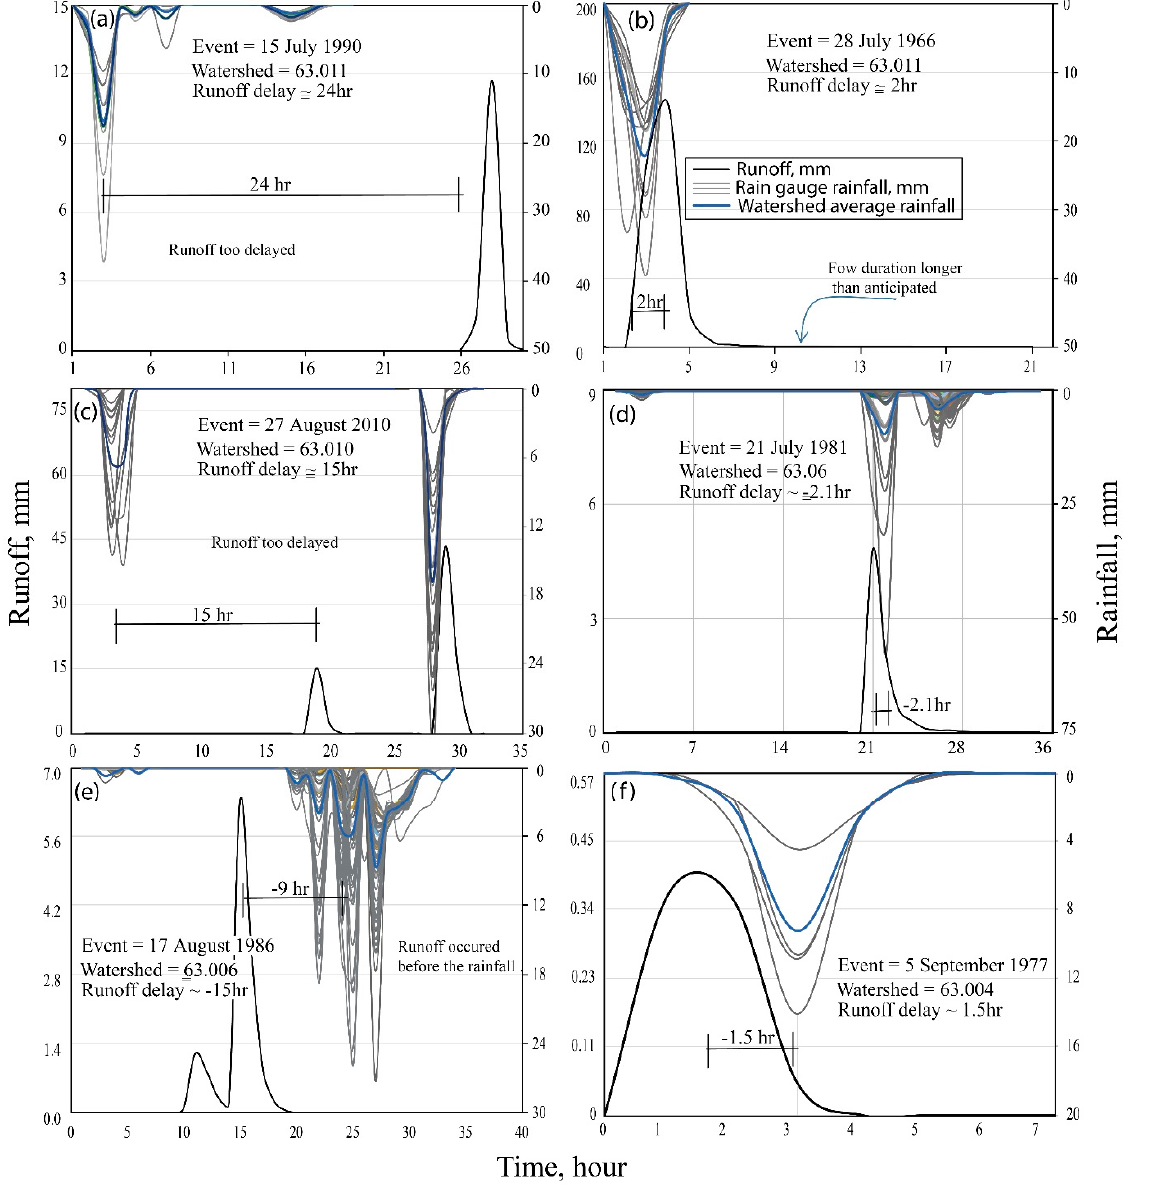
Figure 8. Examples of flagged runoff events, showing runoff (black line) and rainfall from multiple gauges (gray lines) on the inverted y-axis. The solid blue line represents conditional mean of the different rain gauges in the watersheds. The figure shows excessively delayed runoff in ( a , c ), runoff events not associated with the corresponding rainfall in ( b , d ), and runoff occurred before the rainfall was being recorded in ( e , f